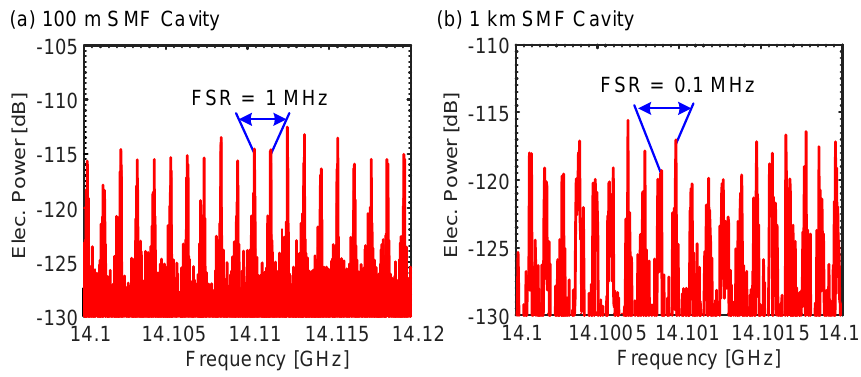
Figure 12. Resolved longitudinal modes of the self-seeded RSOA-FCL for: ( a ) 100 m and ( b ) 1 km SMF cavities. FSR = c /2 nL , where c , n , L are the speed of light in vacuum, the refractive index and the length of the SMF